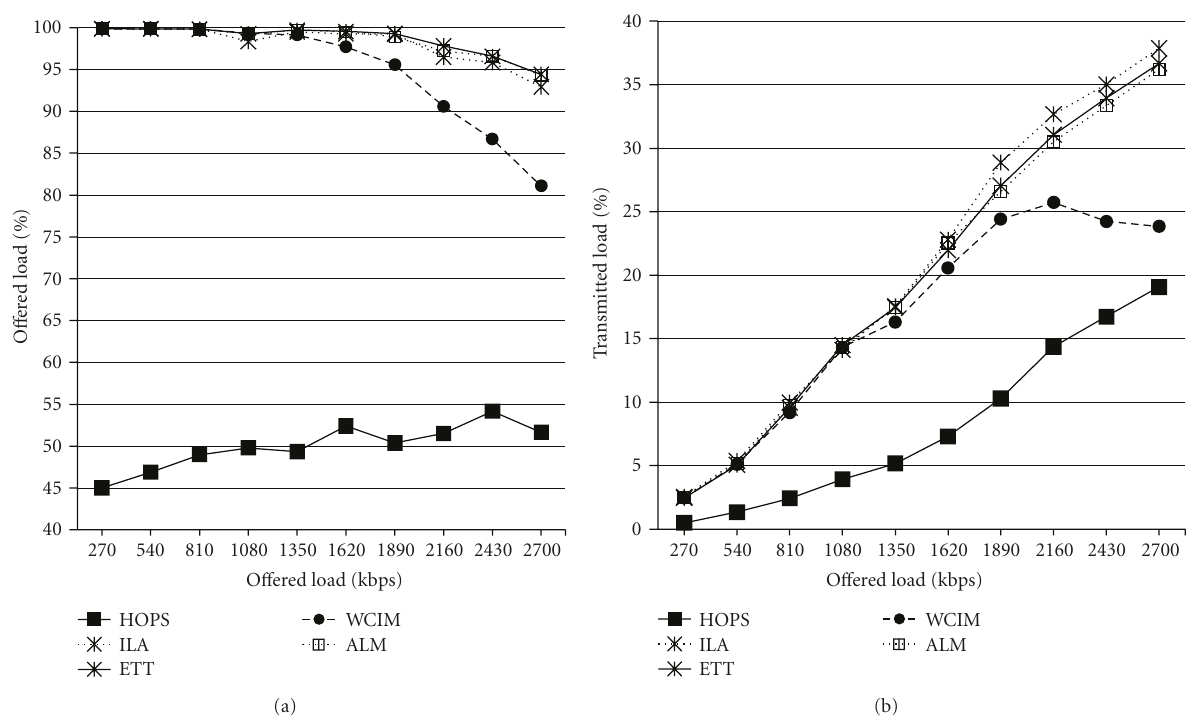
Figure 11: Scenario 5 additional results. (a) Transmitted load. (b) Packet loss rate of transmitted